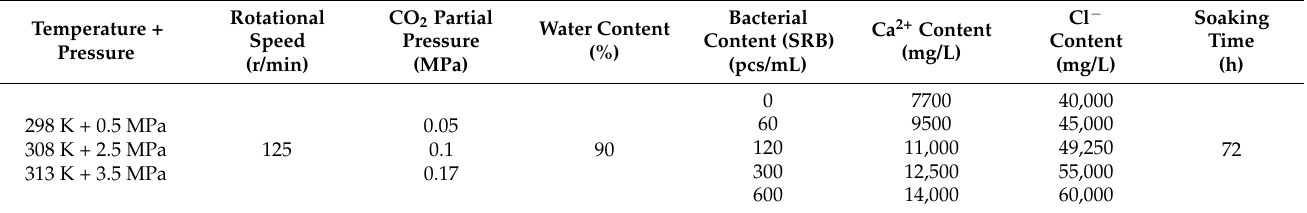
( c ) Figure 2. Microscopic corrosion morphology of hanging piece under different temperatures and pressure. ( a ) 298 K + 0.5 MPa; ( b ) 308 K +2.5 MPa; ( c ) 313K + 3.5 MPa. 3.2. Effect of CO 2 Partial Pressure on Corrosion Test conditions: temperature and pressure are 308 K and 2.5 MPa, water content is 90%, bacteria content is 0 pcs/mL, total mineralization is 100,000 mg/L, Ca 2+ + Mg 2+ content is 11,000 mg/L, Cl − content is 49,250 mg/L, CO 2 partial pressure is designed as 0 MPa, 0.05 MPa, 0.10 MPa and 0.17 MPa respectively. Through the above experimental conditions in order to carry out dynamic corrosion experiments on 20# steel, a clearly different CO 2 partial pressure on the corrosion rate of the law, CO 2 partial pressure, and 20# steel corro- sion rate relationship curve is shown in Figure 2. Figure 3 shows that the 20# steel corrosion rate with the CO 2 partial pressure in- creases the trend of change, mainly with the increase in CO 2 partial pressure, the corrosion rate gradually increases, and contains CO 2 , compared to the conditions without CO 2